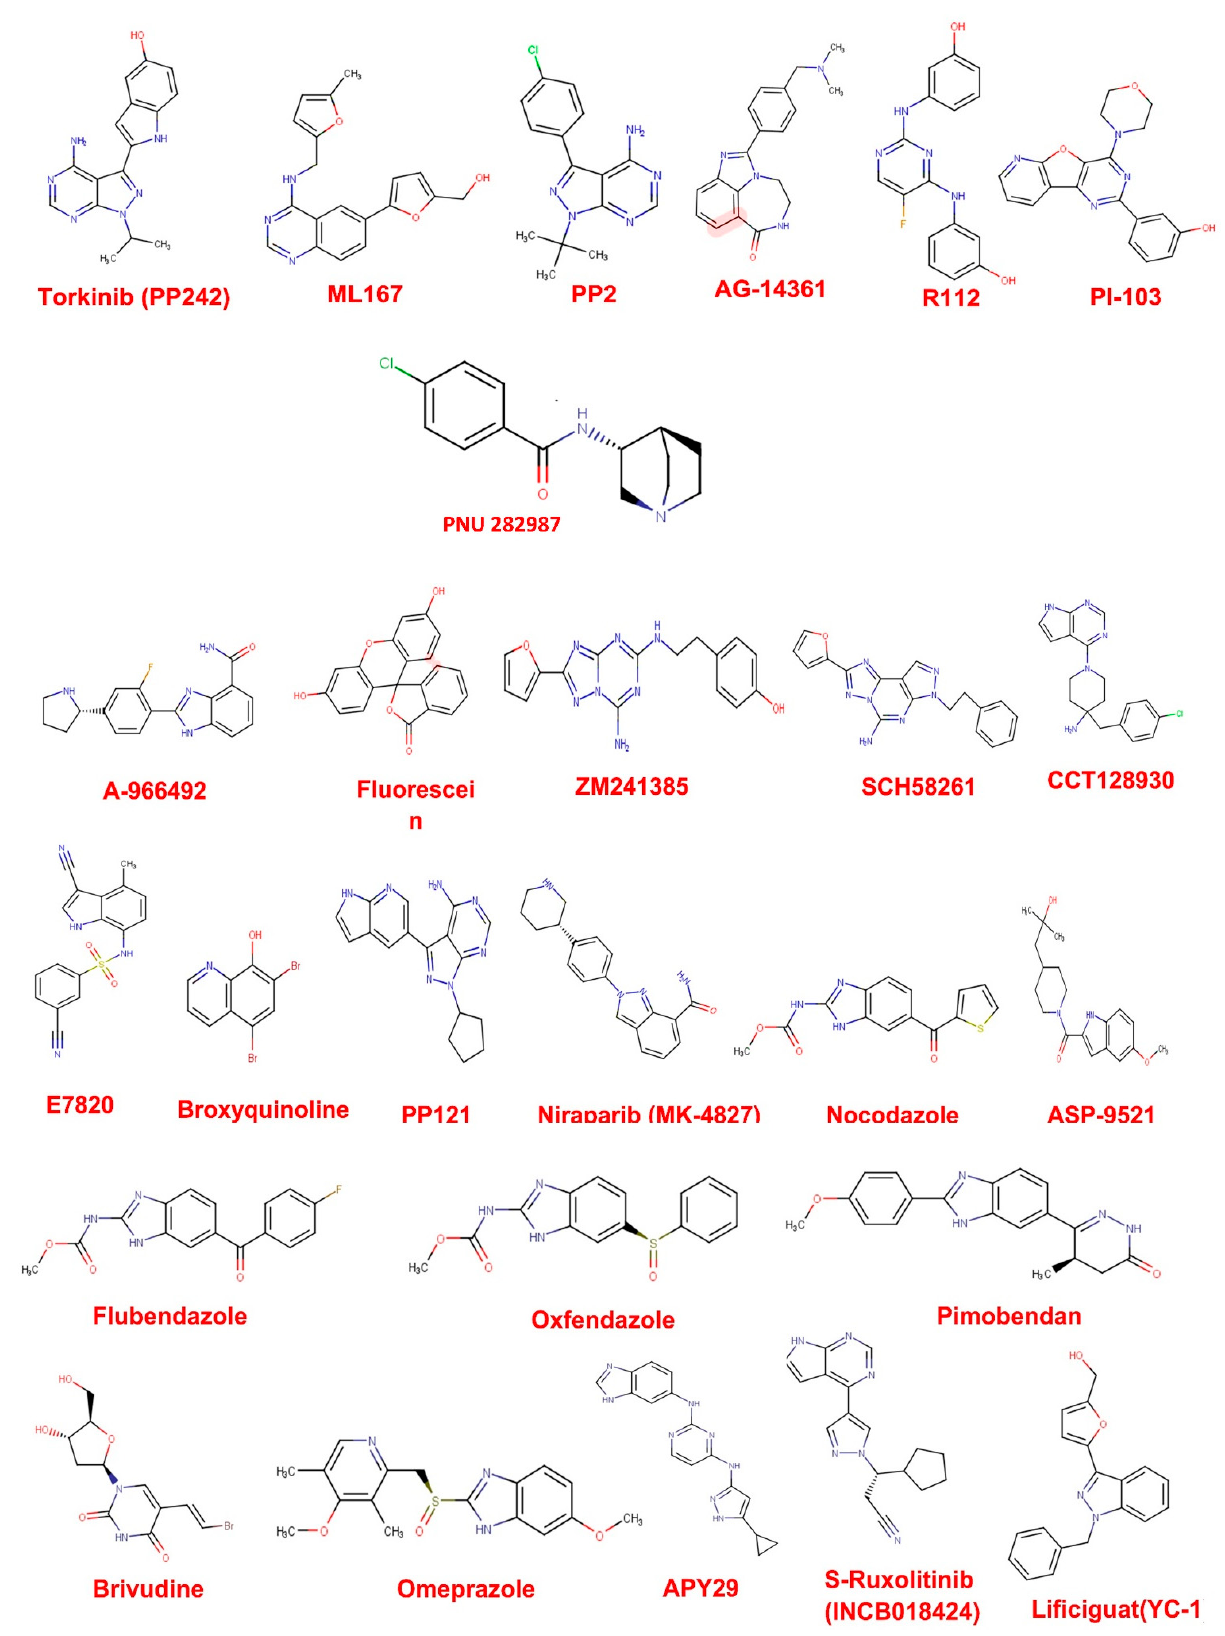
Figure 2. Chemical structures of druglike compounds from sellekchem chemical repository for anti-cancer compounds in